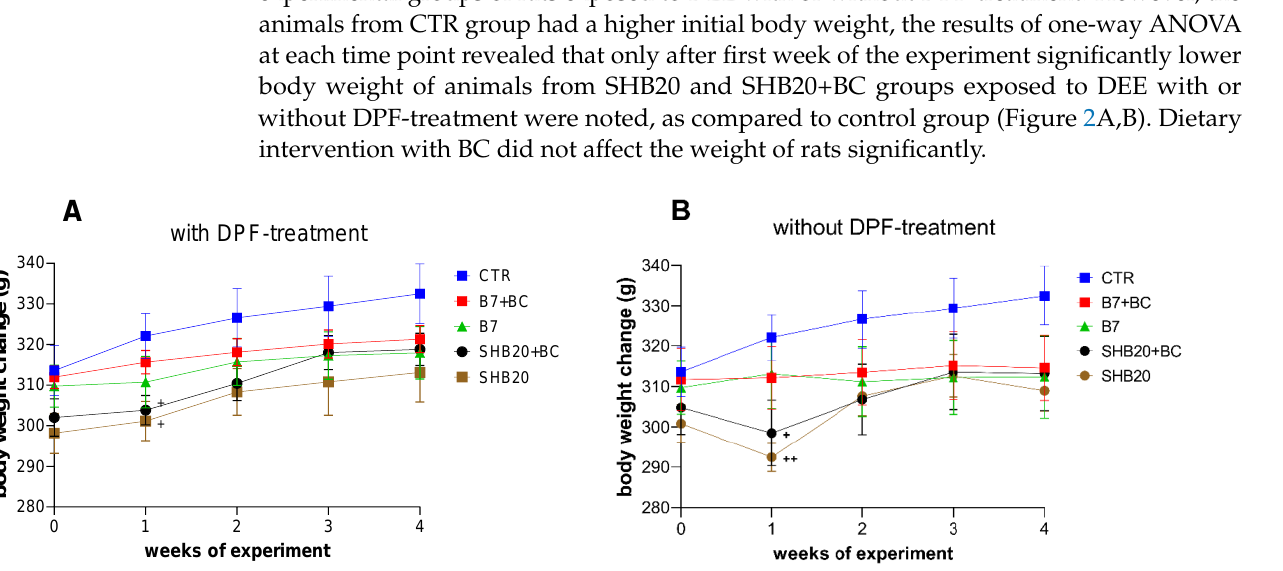
Figure 2. Body weight change of rats exposed to DEE from B7 or SHB20 biofuels with ( A ) or without ( B ) DPF-treatment and with or without blackcurrant pomace supplementation (BC) during the experiment. CTR — control group; B7 — 1st generation biofuel; SHB20 — 2nd generation biofuel; BC — blackcurrant pomace; DPF — diesel particulate filter. Data are expressed as mean ± SEM; + — Statisti-